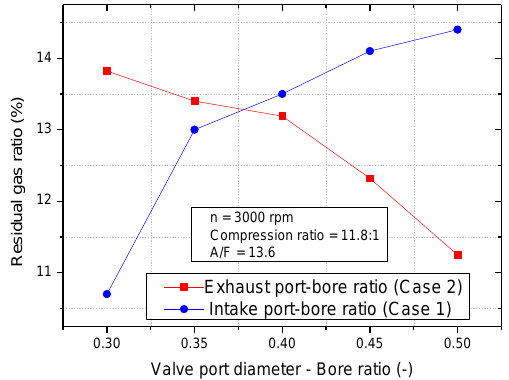
Figure 12. Residual gas fraction versus VPD / B.